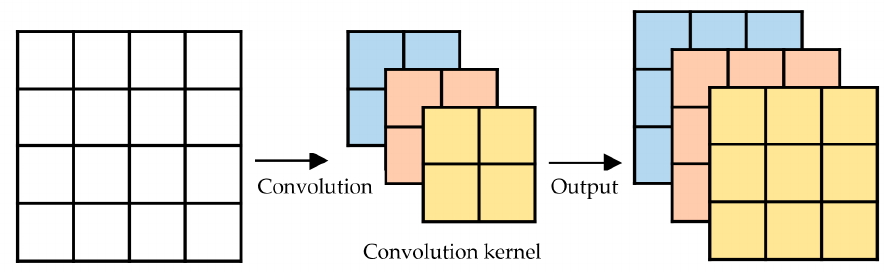
Figure 1. Example of the 2D convolution operation.